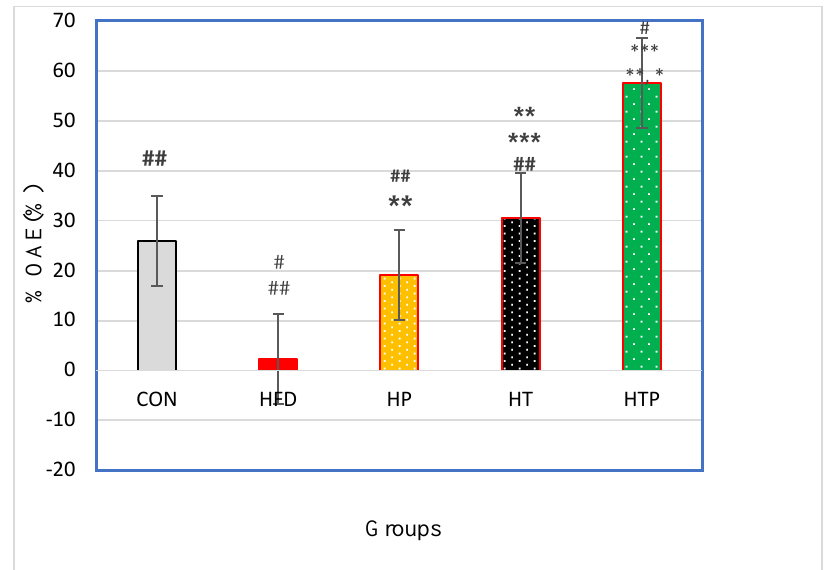
Figure 4. Comparison of %OAE (Mean ± SE) in the experimental groups. * p < 0.05: significant difference with the CON group; ** p : significant difference with the HFD group; *** significant difference with the HP group; #: significant difference with the HT group; ##: significant difference with the HTP group; CON: control, HFD: high-fat diet, HP: high-fat diet + probiotic, HT: high-fat diet + HIIT training, HTP: high-fat diet + HIIT training + probiotic. OAE: open arm entries.